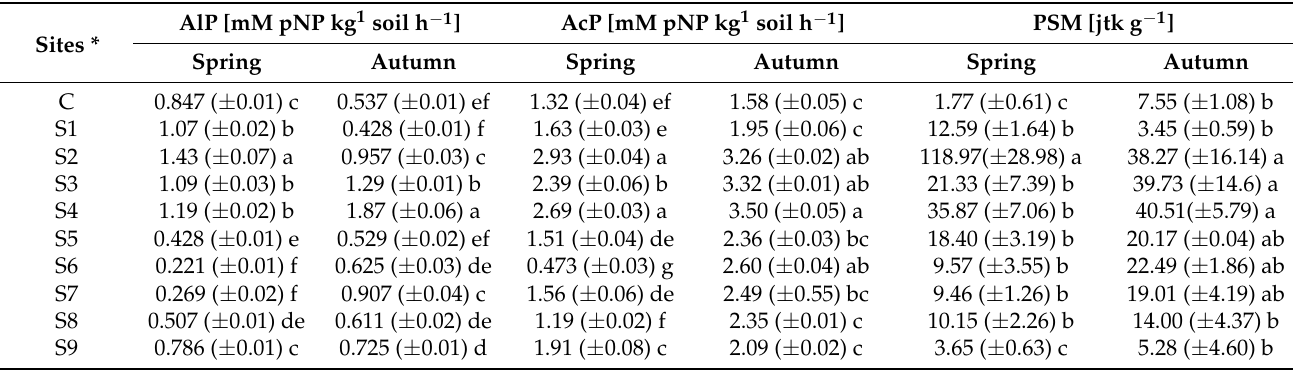
Table 5. Activity of alkaline (AlP) and acid phosphatase (AcP) and number of phosphate solubilizing microbes (PSM) in the